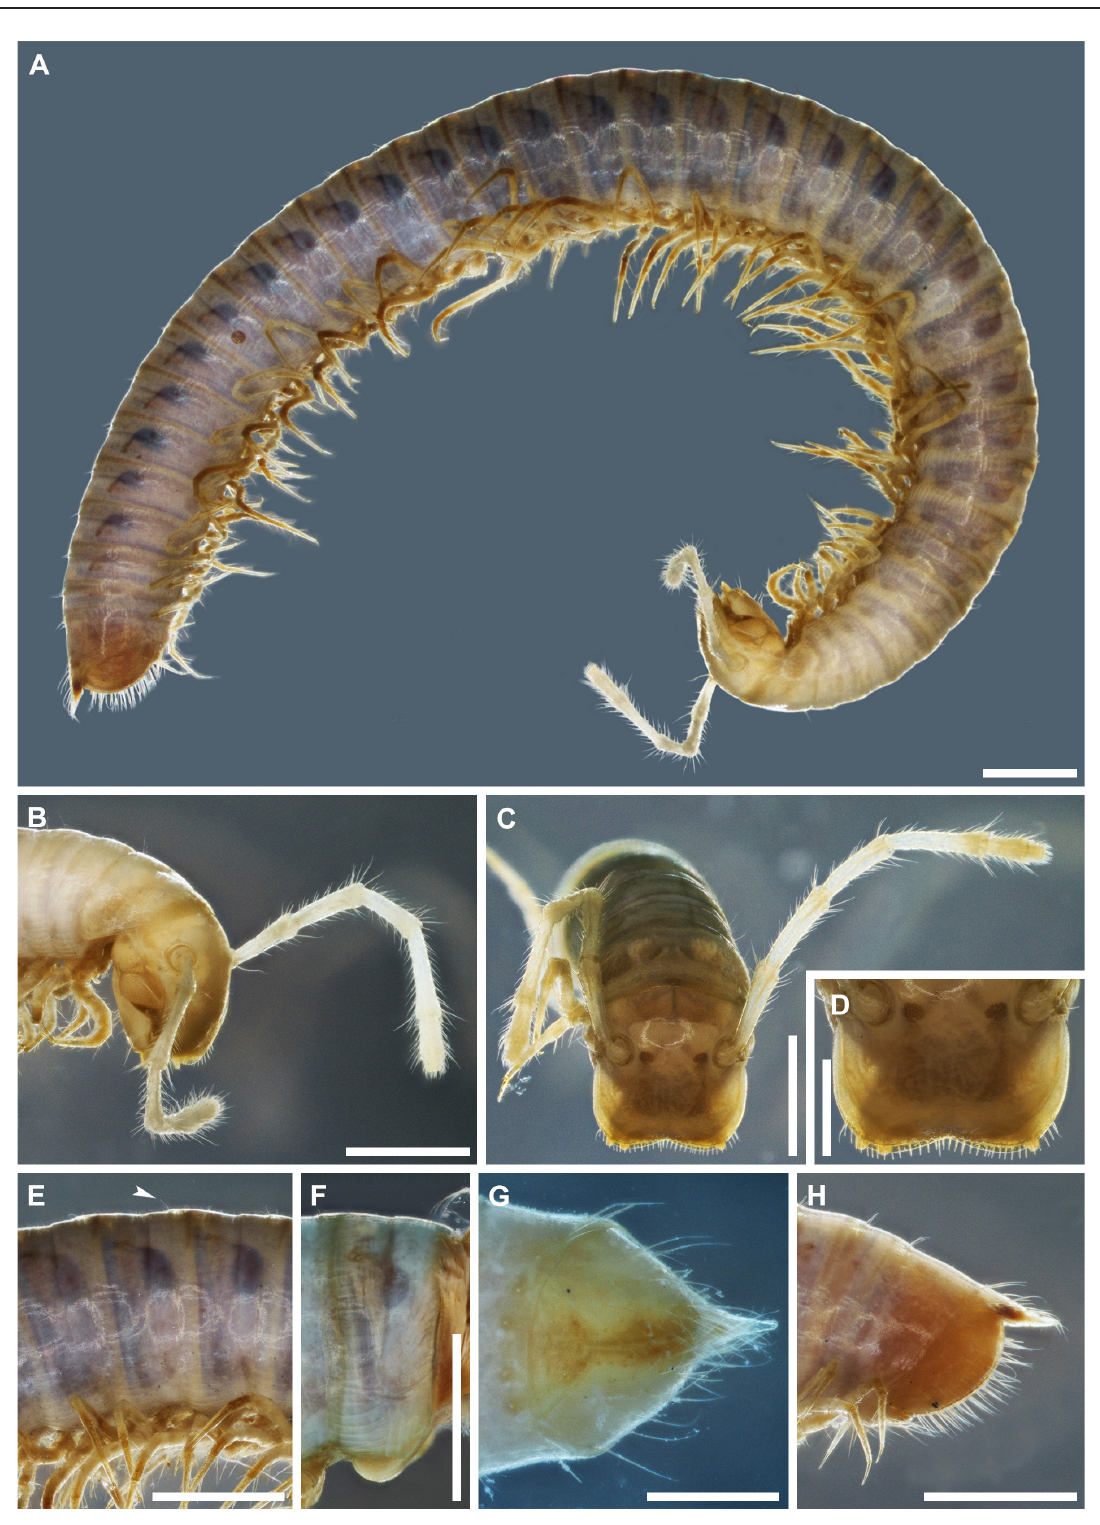
Fig. 36. Leucogeorgia caudata sp. nov., type ♂♂ from Novoafonskaya Cave. A . Holotype, habitus, lateral view (ZMUM). B . Holotype, head, lateral view. C . Paratype, head and anterior part of body, anterior view (IZB). D . Paratype, labrum, dorsal view (IZB). E . Holotype, midbody rings, lateral view. F . Paratype, body ring 7, lateral view (IZB). G . Paratype, telson, ventral view (IZB). H . Holotype, teslon, lateral view. Arrow indicates metazonal seta. Scale bars: A–C, E–F, H = 1 mm; D, G = 0.5